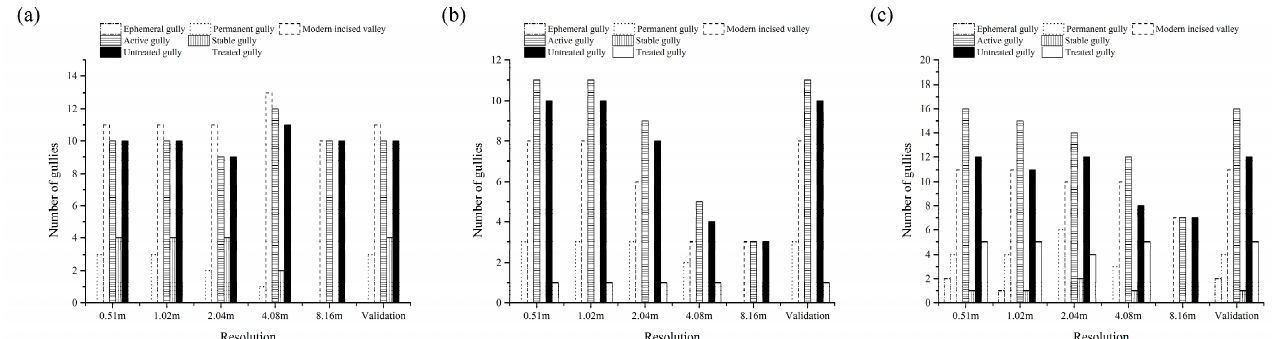
Figure 4. Number of gullies. ( a – c ) Number of gullies visually interpreted in validation areas I, II and III, respectively. Table 3. Accuracy evaluation of interpretation of permanent gullies and modern incised valleys. Resolution Type of Gully